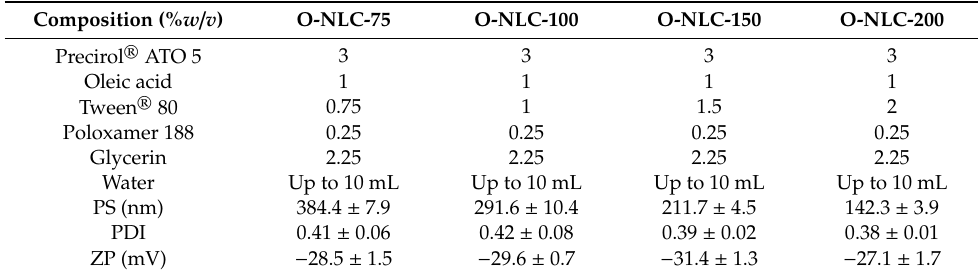
Table 3. E ff ect of di ff erent Tween ® 80 concentrations on particle size, polydispersity index and zeta potential of NLC placebos (mean ± SD, n =